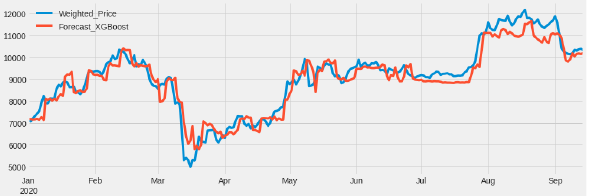
Table 3. Performance Analysis of ARIMAX